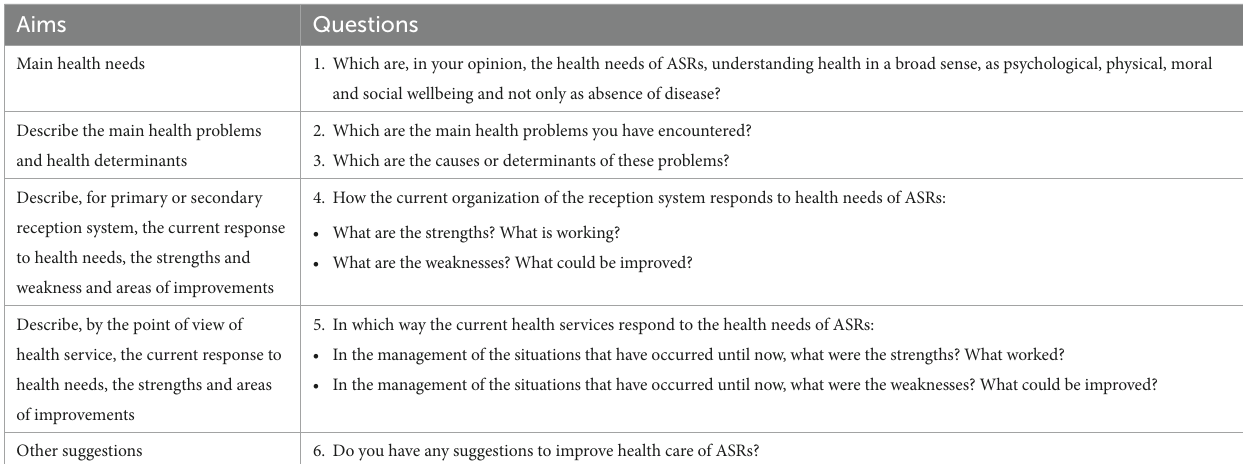
TABLE 2 Semi-structured focus group (FG) questions.